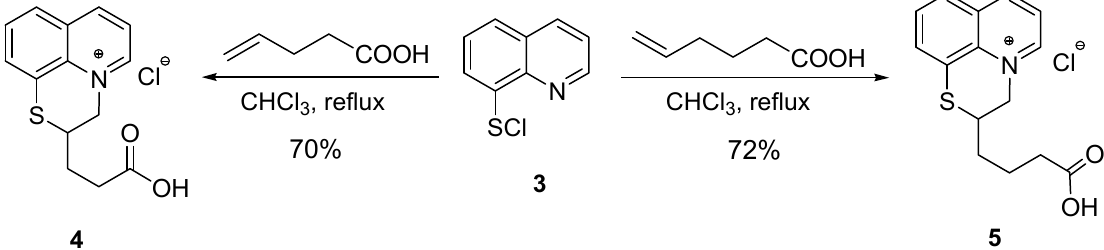
Scheme 3. Synthesis of 2-(3-carboxyethyl)- and 2-(3-carboxypropyl)-2 Н ,3 Н -[1,4]thiazino[2,3,4- ij ]quinolin-4-ium chlorides 4 and 5 from sulfenyl chloride 3 , 4-pentenoic and 5-hexenoic acids.